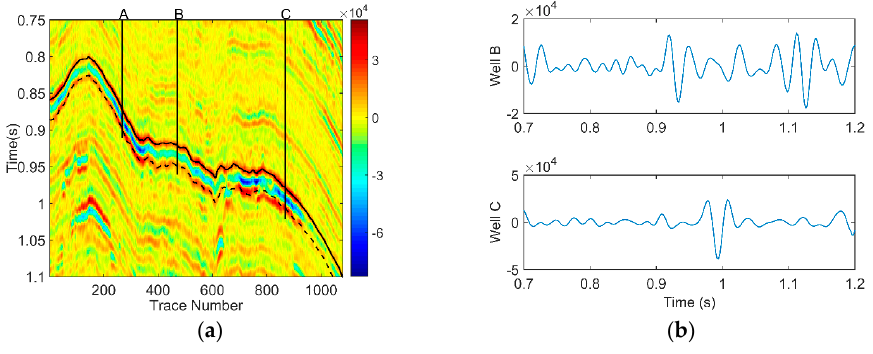
Figure 6. ( a ) Field seismic data; ( b ) waveform of well B and well C.